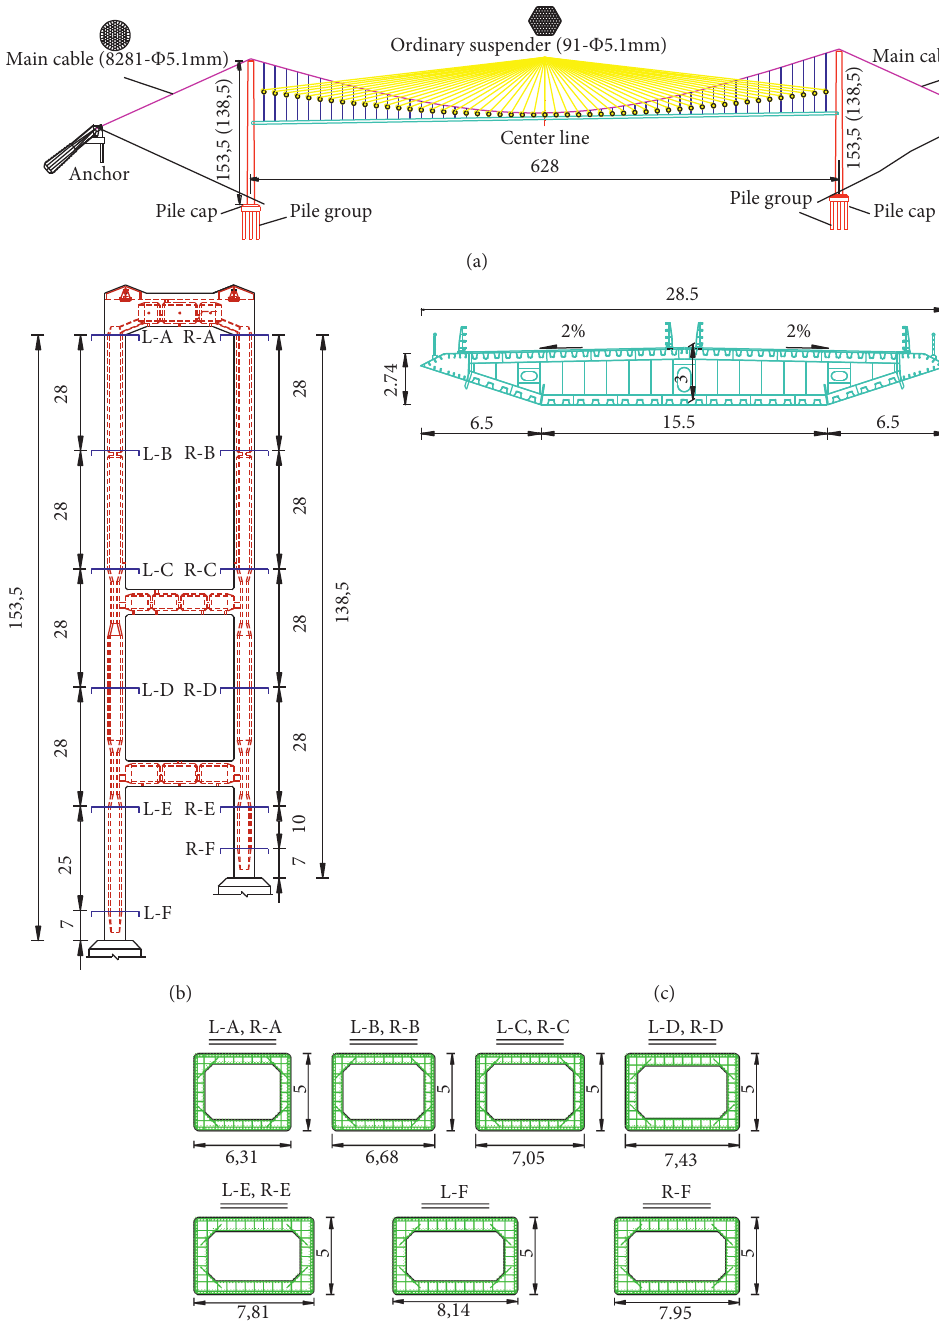
Figure 3: Puli Bridge. (a) A general view of the bridge. (b) Photos of the tower. (c) Cross section of the deck. (d) Cross section of the tower (units: